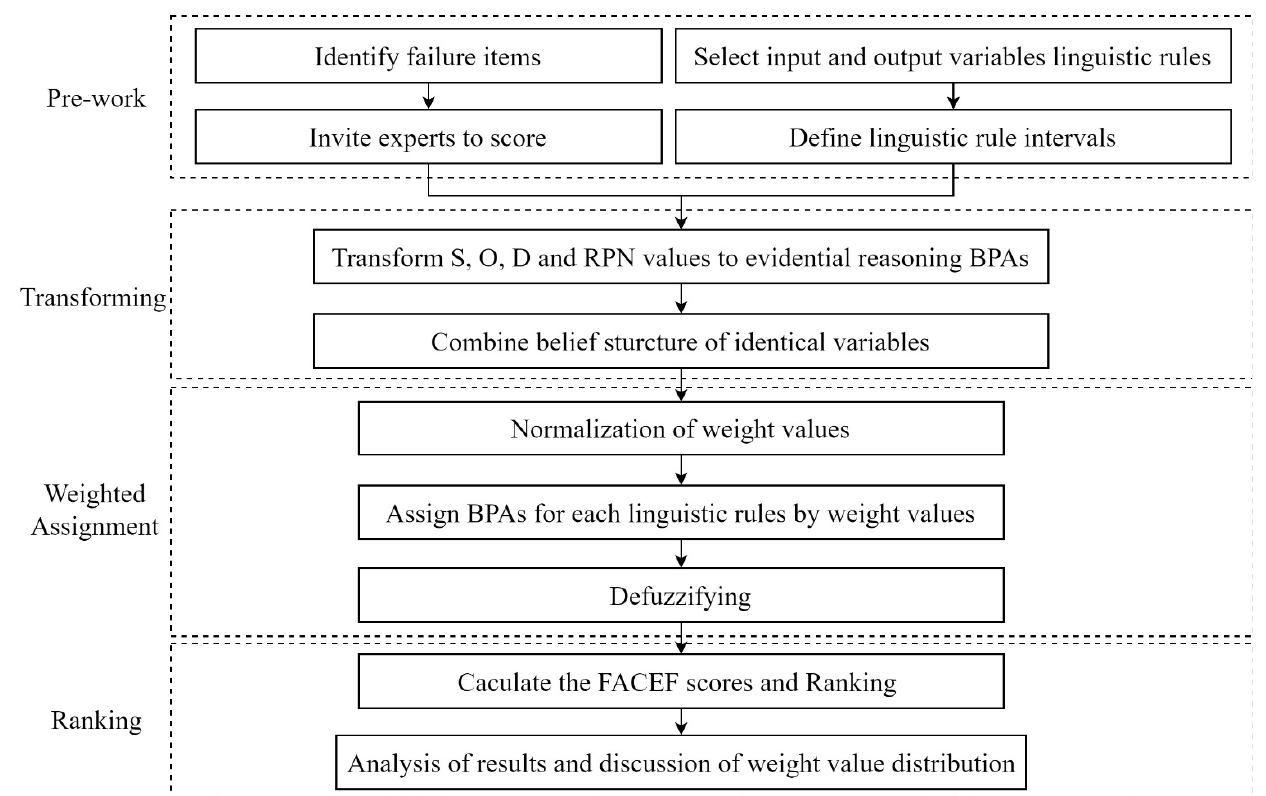
Figure 4. Flowchart of FACEF.